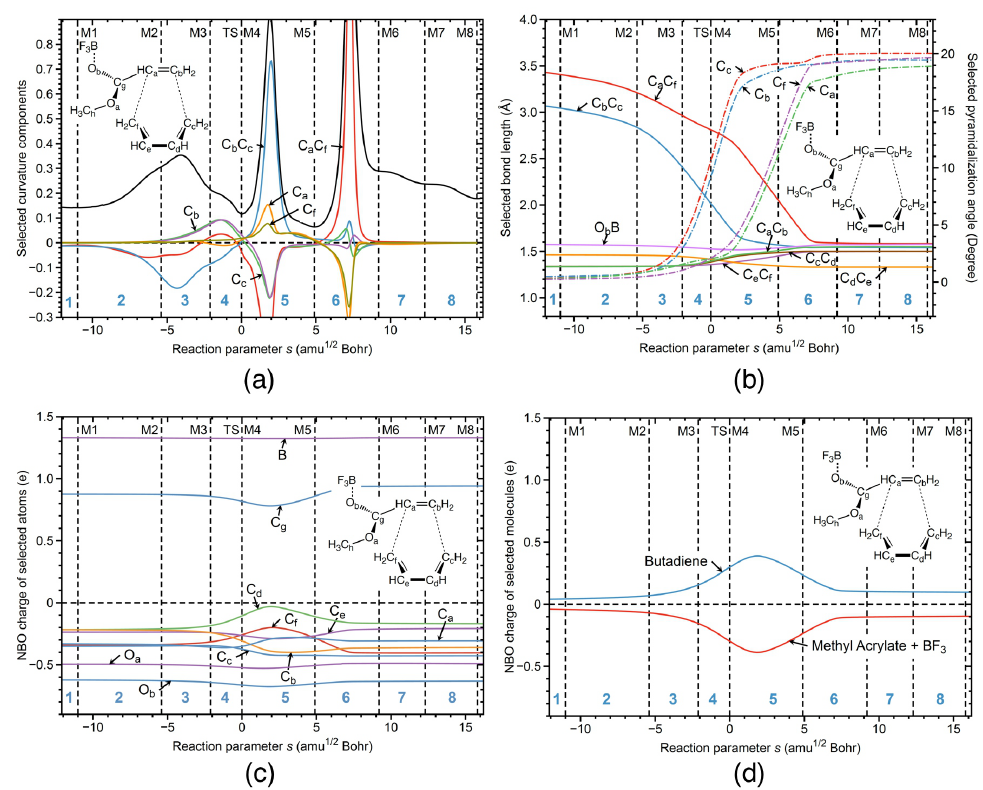
Figure 4. R1cw reaction properties along the reaction path; ( a ) decomposition of the reaction curva- ture into selected components—the bonds are shown as two character labels, and the pyramidalization angles shown as a one character label; ( b ) change of the selected geometrical parameters—the bonds are shown as two character labels, and the pyramidalization angles shown as one character label; ( c ) change of the NBO charges of the selected atoms; ( d ) change of the NBO charges of the selected molecules. B3LYP/6-311+G(2d,p)/AMBER level of